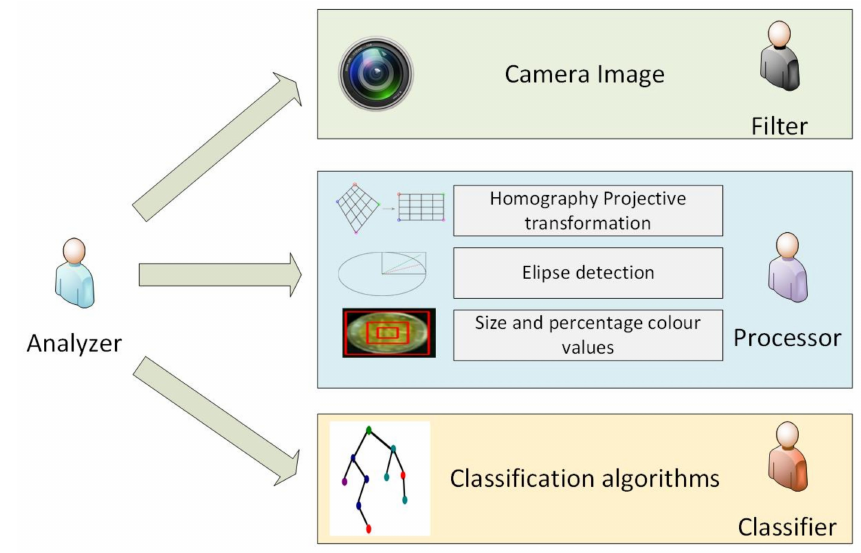
Figure 3. Stages of the proposed process for coins